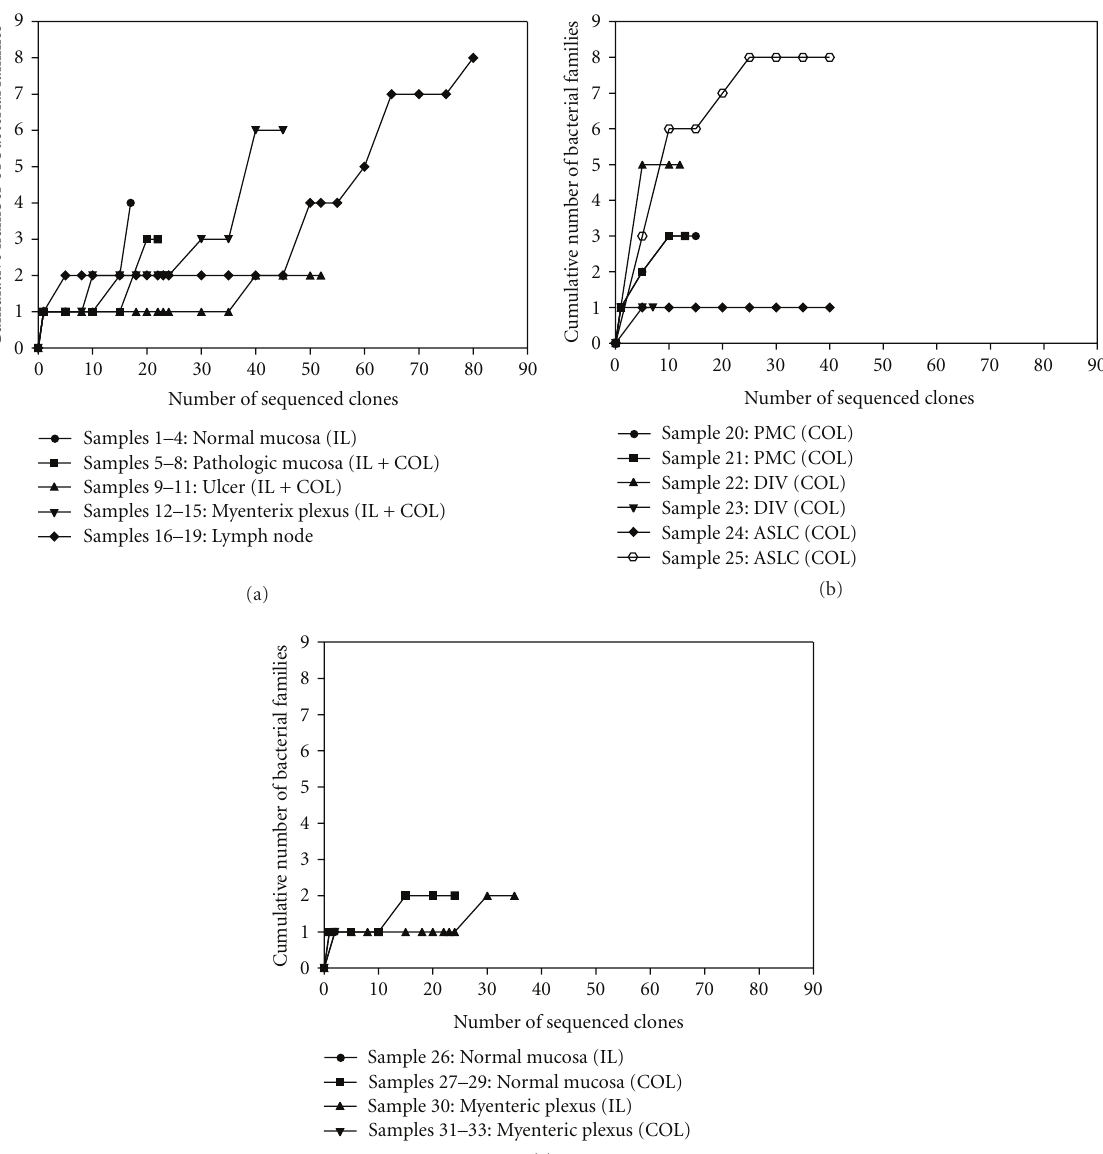
Figure 2: Plots of the cumulative numbers of detected genuinely present bacterial families versus the total number of bacterial sequences analysed for CD patients (a), disease controls (b), and healthy controls (c). ASLC: acute self-limited colitis, PMC: pseudomembranous colitis, DIV: diverticulitis, AC: adenocarcinoma. IL: ileum, COL: